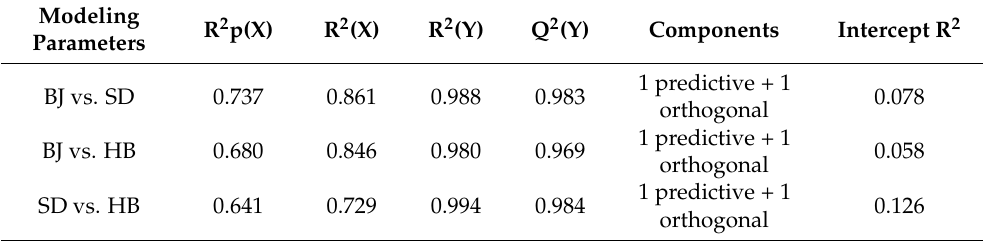
Figure 1. The OPLS-DA analysis of the HS-SPME/GC-MS data. ( a ) score plot for BJ vs. SD; ( b ) validation plot of 200 permutation tests for BJ vs. SD; ( c ) score plot for BJ vs. HB; ( d ) validation plot of 200 permutation tests for BJ vs. HB; ( e ) score plot for SD vs. HB; ( f ) validation plot of 200 permutation tests for SD vs. HB. The slope of R 2 > 0 together with the intercept of Q 2 on the y-axis < 0 indicating a valid model. Table 4. OPLS-DA model parameters for the three cultivation regions of BJ, SD, and HB. R 2 p(X) represents the variance related to class separation, R 2 (X) represents the total explained variance, R 2 (Y) represents the model developing ability, Q 2 (Y) represents the cross-validated predictive